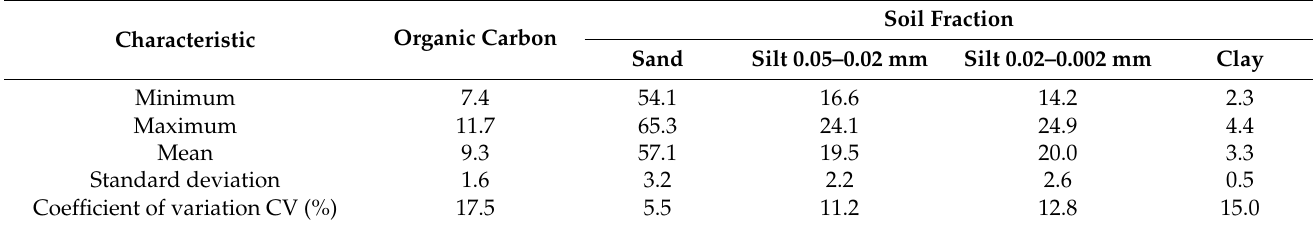
Table 1. Characteristics of organic carbon content (g kg − 1 soil) and soil grain size (% share of each fraction) in experimental fields.